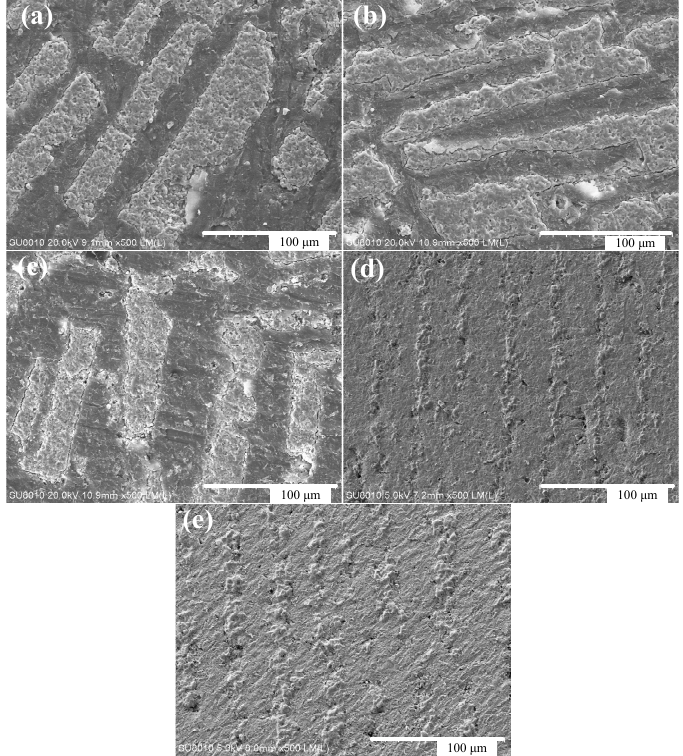
Figure 5. Microscopic morphology of the cross-section of layered Al 2 O 3 /PMMA composites with different initial solid content (freezing temperature is 30 °C): ( a – e ) 15 wt. %, 17.5 wt. %, 20 wt. %, 22.5 wt. %, and 25 wt. %.